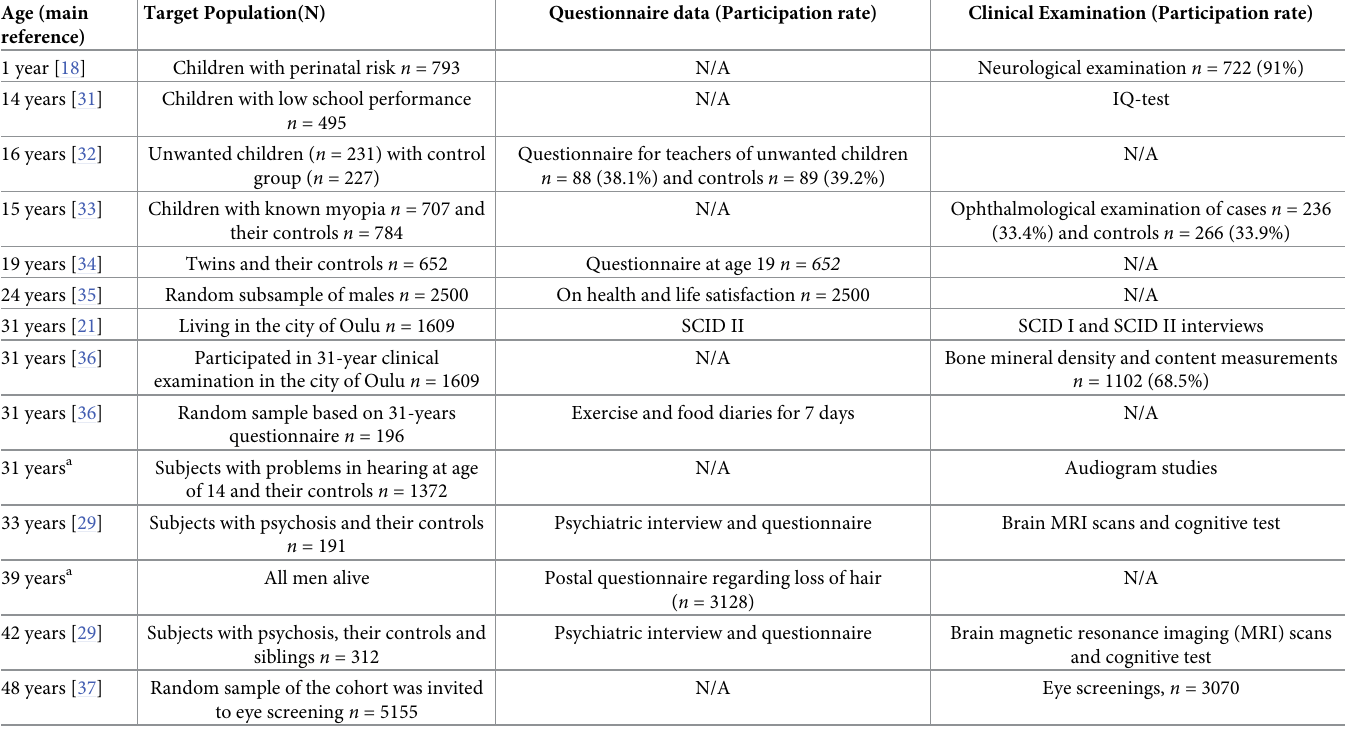
Table 2. Sub-studies of the Northern Finland Birth Cohort 1966